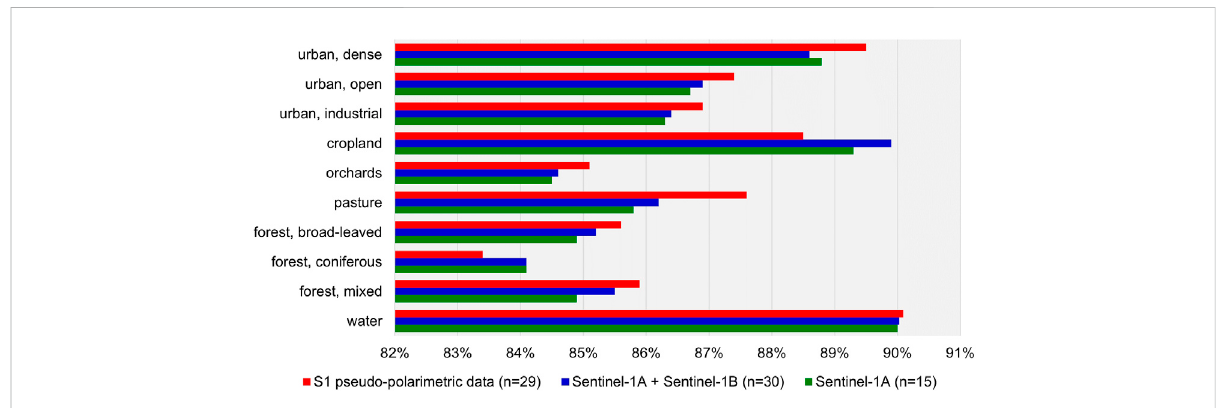
FIGURE 14 Figure 13: Overall accuracies of the random forest classi fi er based on the pseudo-polarimetric product (red), both Sentinel-1 images (blue) and Sentinel-1A data (green).